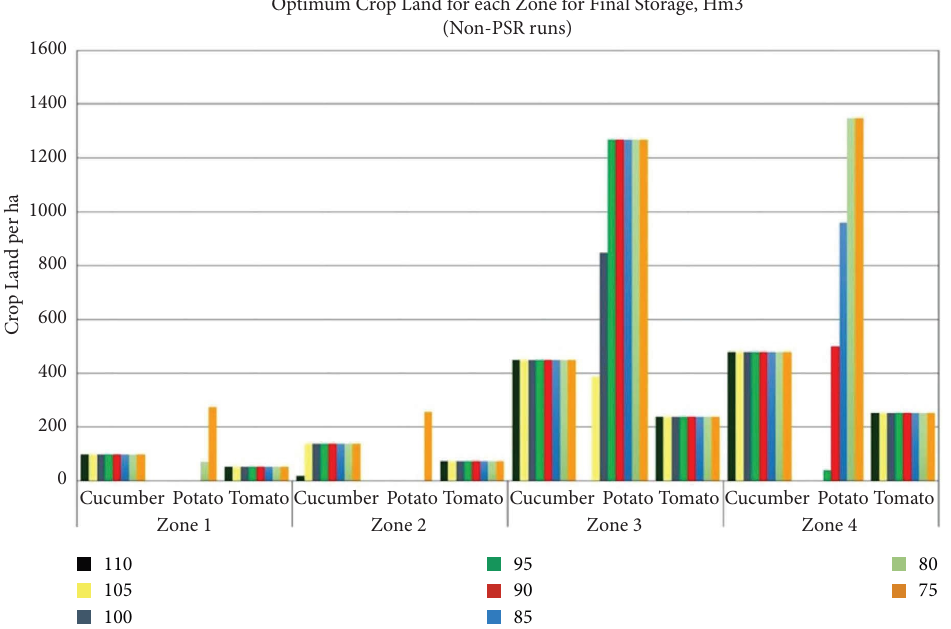
Figure 3: Optimum crop land for each zone using non-PSR scenarios.